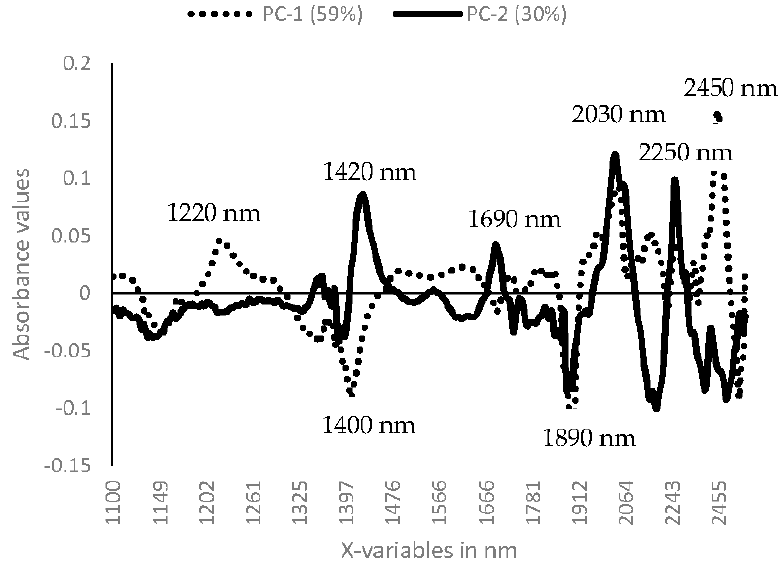
Figure 6. PC loadings plot for 1d-SG + MSC-treated NIR spectra of inoculated kernels in stage-dose classifications.